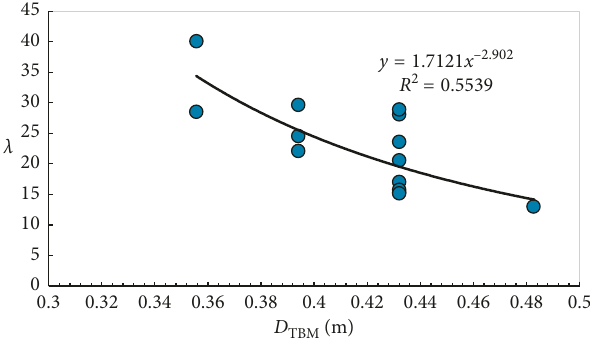
Figure 3: Relationship between λ and TBM diameter.